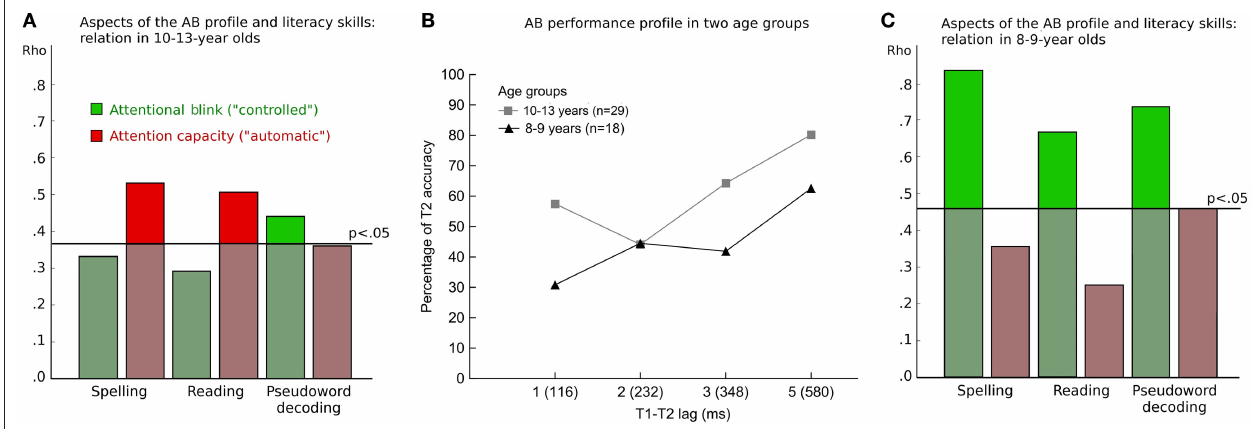
row, with no intervening distractors. The horizontal black line indicates the 5% significance level of rank correlation coefficients in this group. (B) Percentage of accurate T2 report given T1 identification at four temporal lags of the AB task. Values represent means of 29 older children (gray squares) and 18 younger children (black triangles). (C) Bar plot showing the absolute rank correlation between the same measures described in (A) , calculated across children in the younger (8–9 years) group. The horizontal black line indicates the 5% significance level of rank correlation coefficients in this